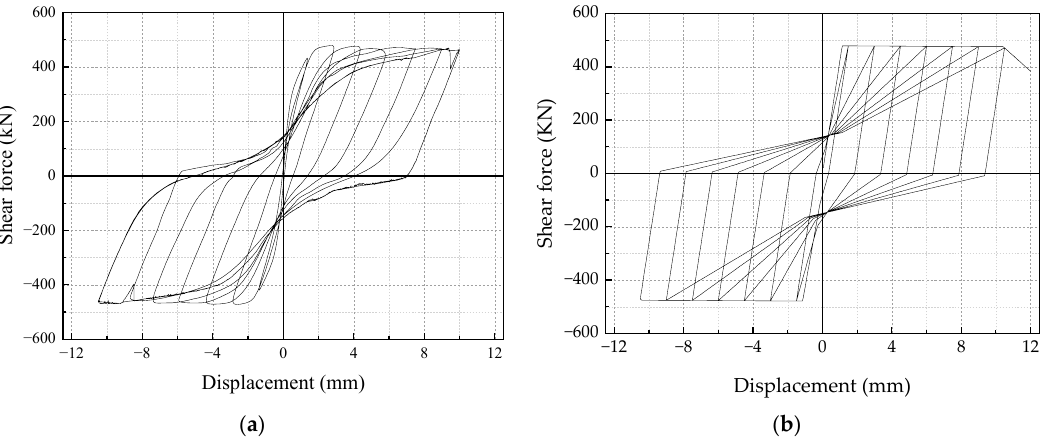
Figure 9. Hysteretic curve of the RC short column. ( a ) SMM model; ( b ) IMK model .